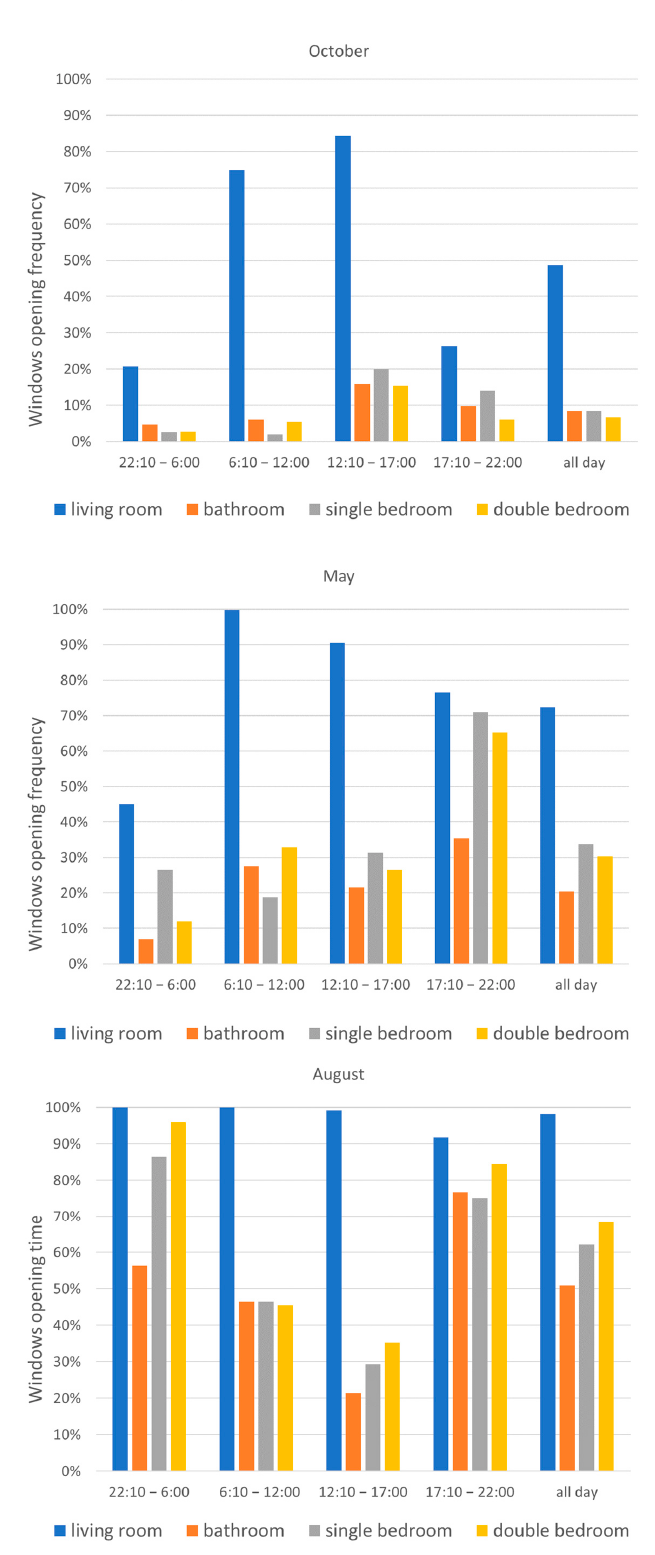
Figure 9. Fraction of each time frame when windows are open in the different rooms of apartment A during October 2017, May 2018, and August